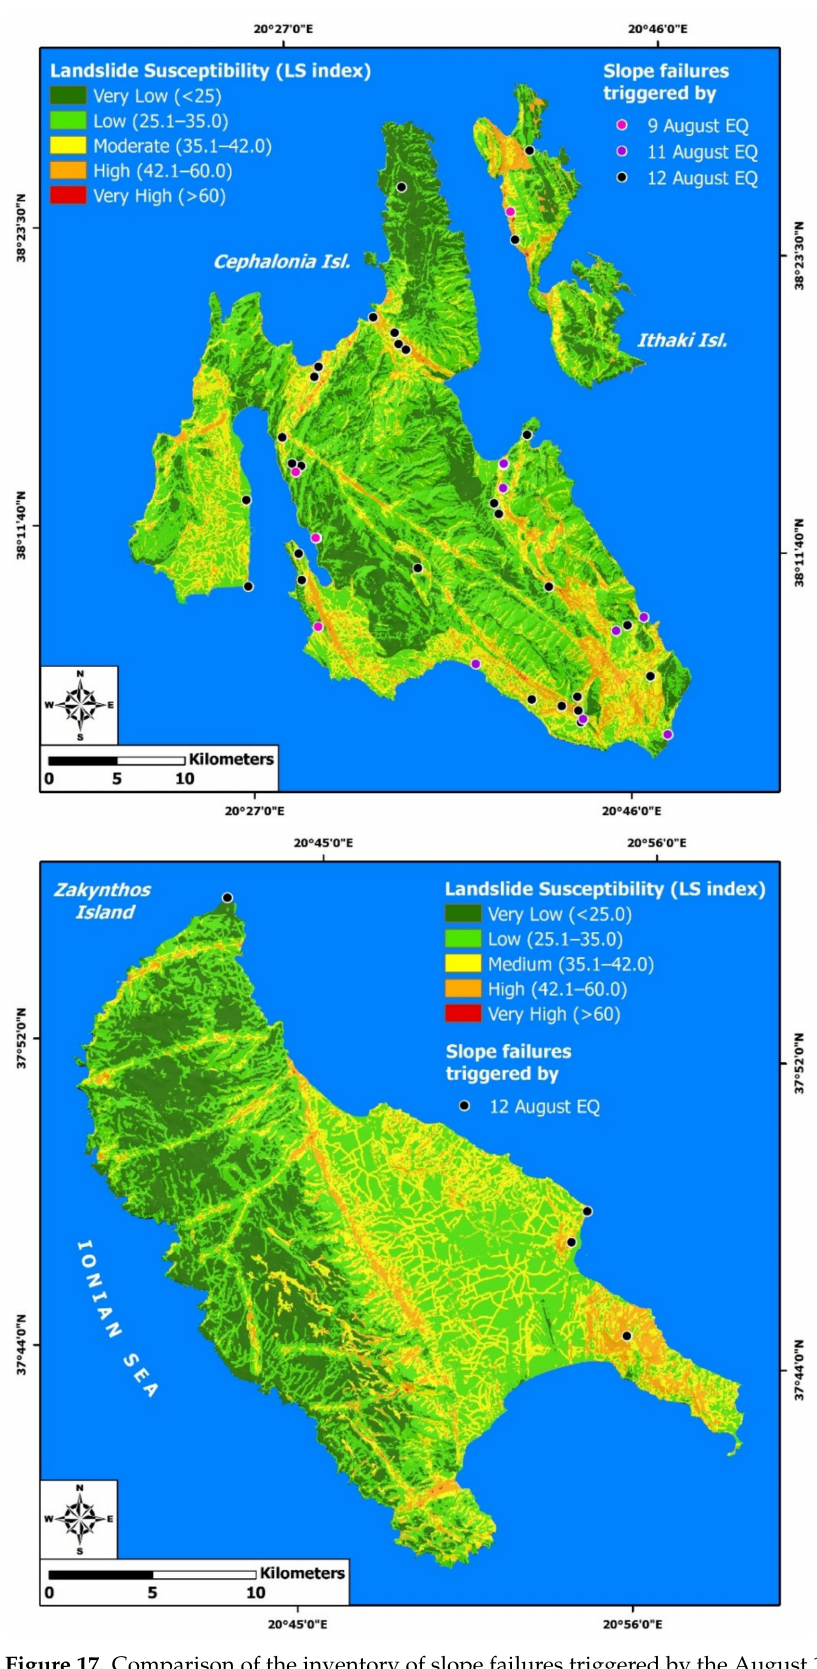
Figure 17. Comparison of the inventory of slope failures triggered by the August 1953 earthquakes in Cephalonia, Ithaki and Zakynthos with the landslide-susceptibility maps of the